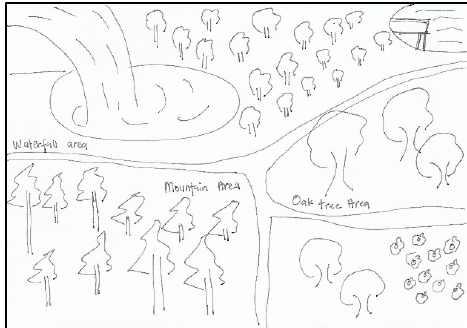
Figure 1. Rough sketch of the map of the in-game